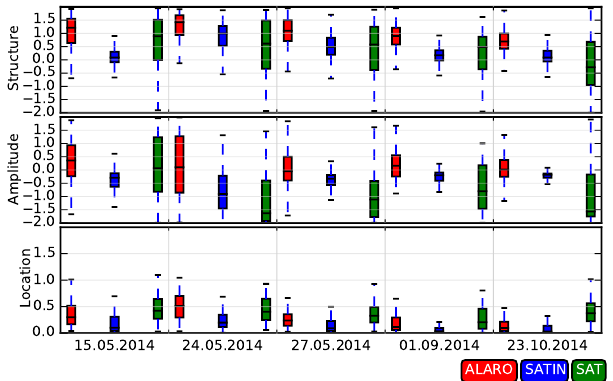
Figure 3. Comparison of pure (translational) nowcasting with NWP: relative RMSE, MAE and Bias averaged over July for ALARO (5km), AROME (2.5km) and SATIN.